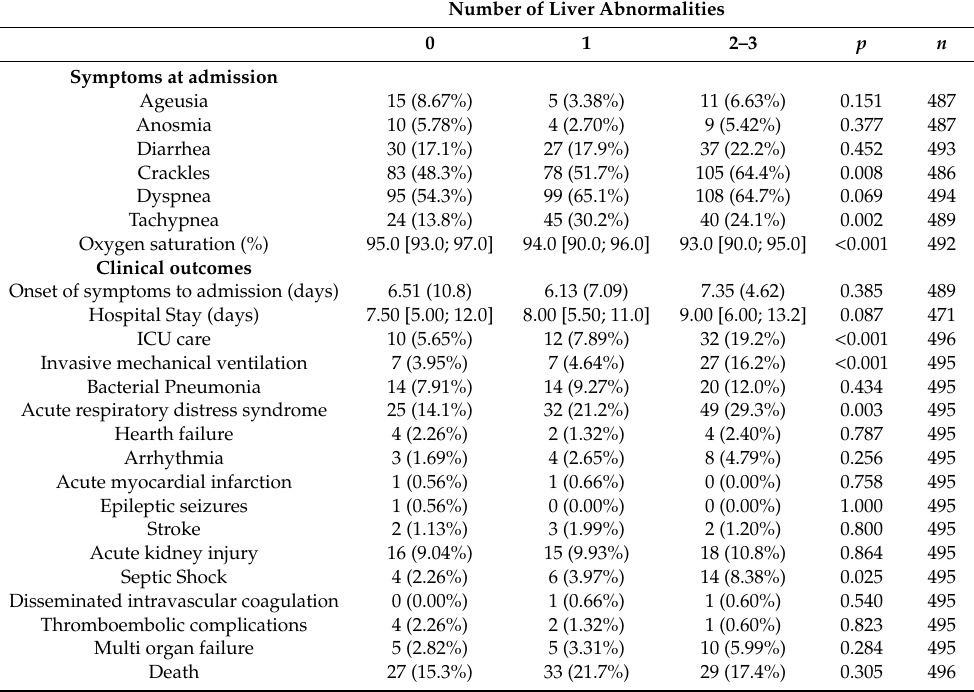
Table 4. Symptoms at admission and clinical outcomes by the number of liver abnormalities. Data represent number of cases (%) for the categorical variables and mean (SD) or mean (IQR) for the continuous parametric and non-parametric variables, respectively. p : p -value for the comparison of groups; chi 2 for categorical variables and ANOVA or Kruskal-Wallis for continuous parametric and non-parametric variables, respectively; and n —number of available cases for each variable.